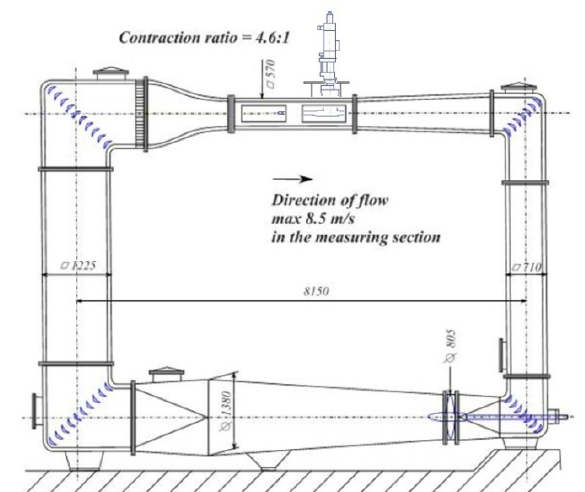
Figure 2: The cavitation tunnel at the University of